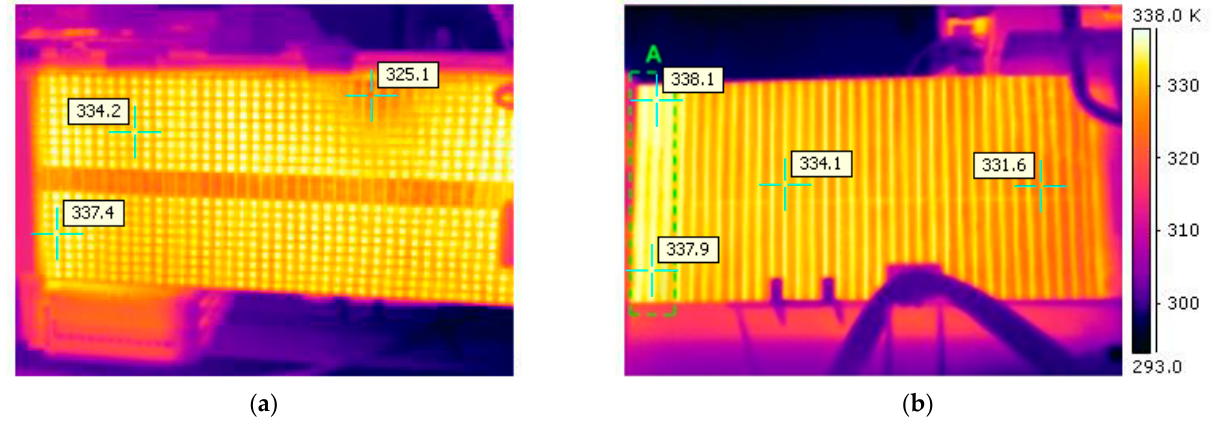
Figure 9. NEXA PEMFC stack infrared (IR)-thermography at P = 1000 W: ( a ) top view and ( b ) side view.